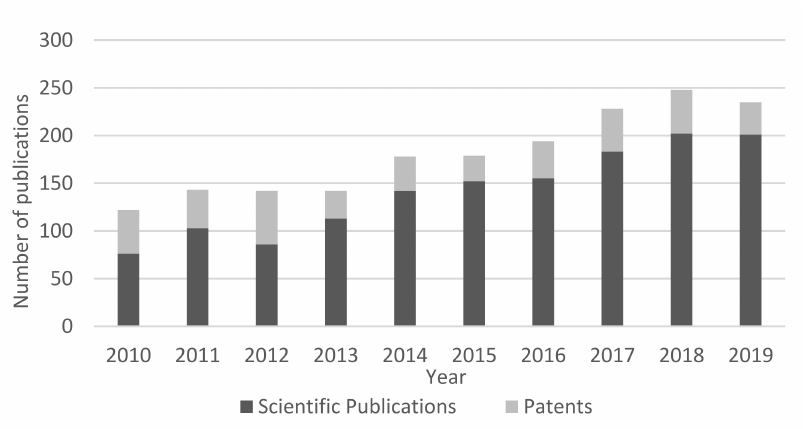
Figure 2. Literature survey of published research articles and patents in cellulose for controlled delivery, using a search query with keywords “cellulose” and “controlled delivery” or “cellulose” and “controlled release”, from 2010 to 2019 via Web of Science™ and WIPO (World Intellectual Property